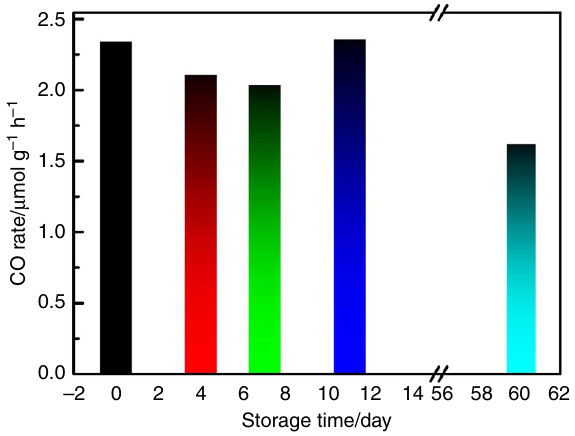
Figure 7 | Stability of hydride-terminated ncSi during storage. CO production rate of ncSi:H film samples after different time spans of storage, which demonstrates the stability of the ncSi:H sample in air without the exposure to light.